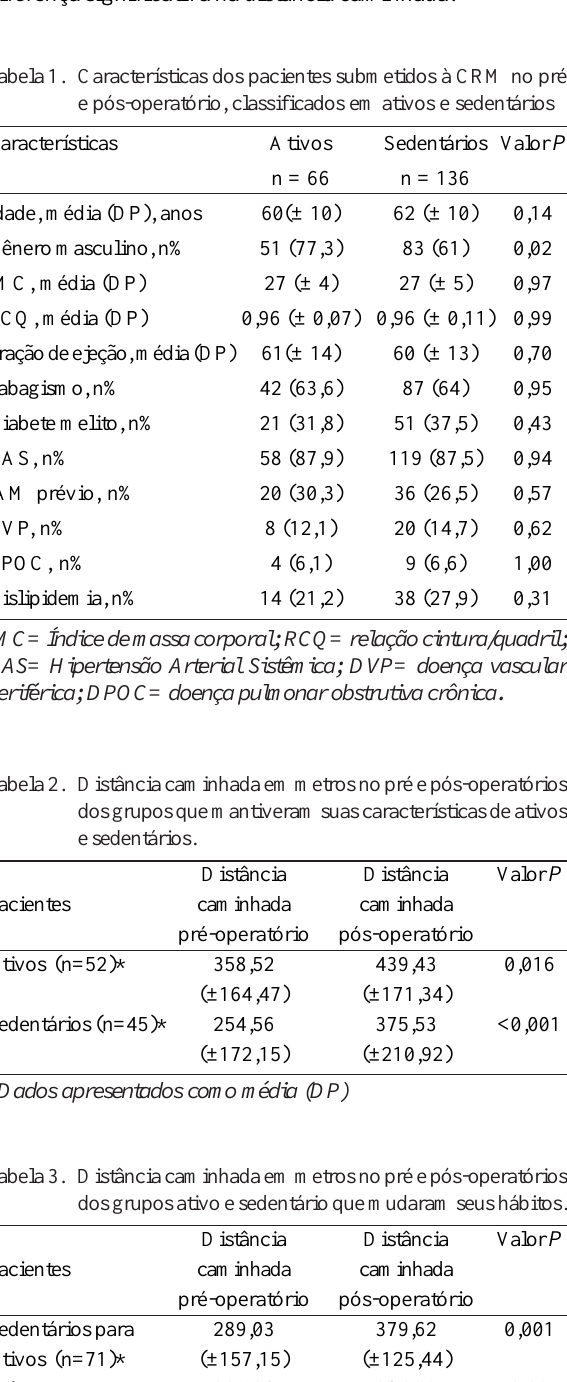
Tabela 1. Características dos pacientes submetidos à CRM no pré e pós-operatório, classificados em ativos e sedentários